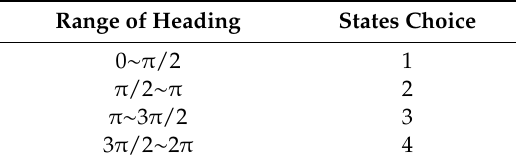
Figure 5. Match selection between observation values and state points: ( a ) based on distance and ( b ) based on heading. Table 1. Match selection based on heading.